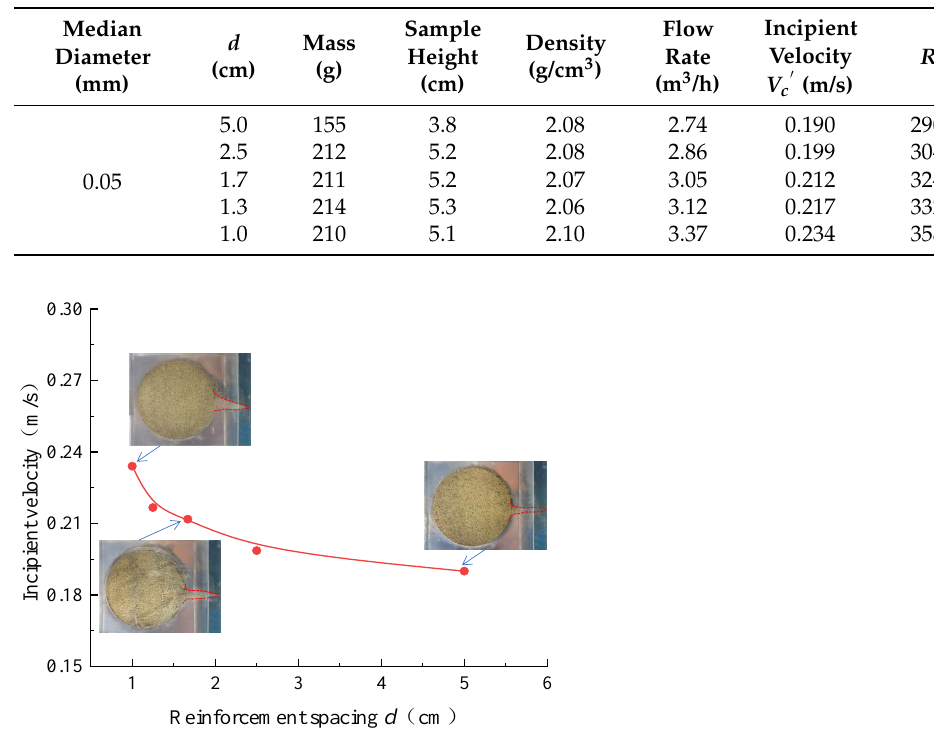
Figure 9. Relationship between incipient velocity of reinforced tailings particles and reinforcement spacing.